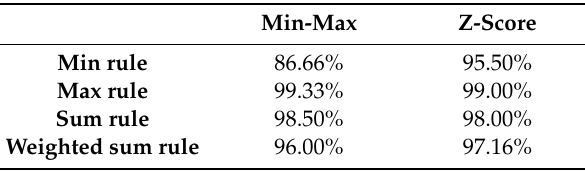
Table 6. Recognition rates of the proposed face–iris multimodal system on CASIA-FERET